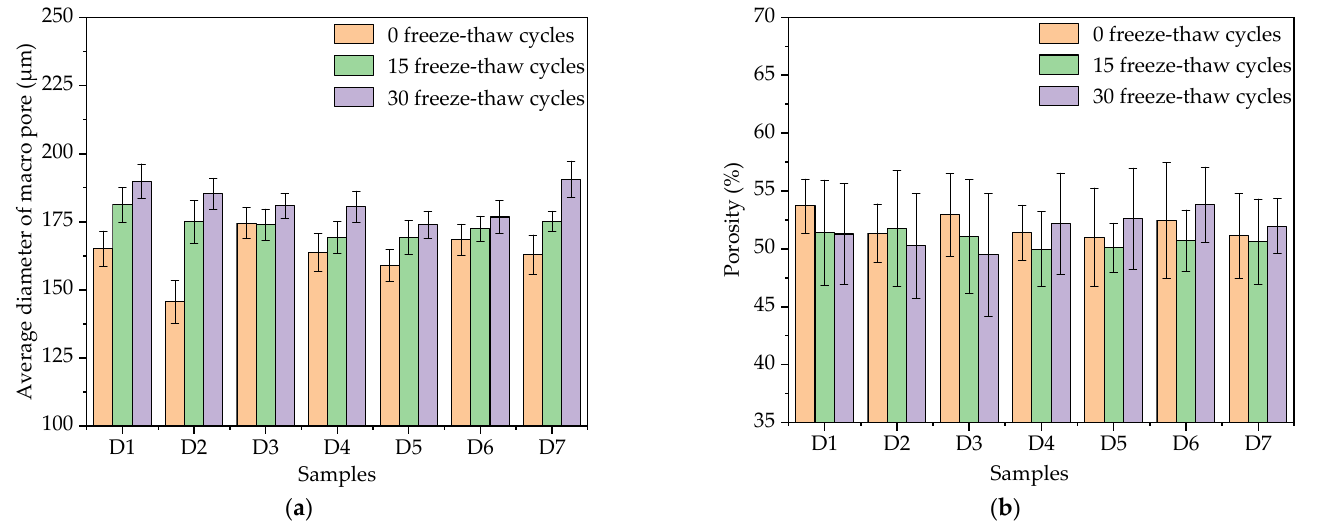
Figure 6. Average macroscopic pore diameter and porosity under freeze–thaw cycles: ( a ) average macroscopic pore diameter under freeze–thaw cycles; ( b ) porosity under freeze–thaw cycles.